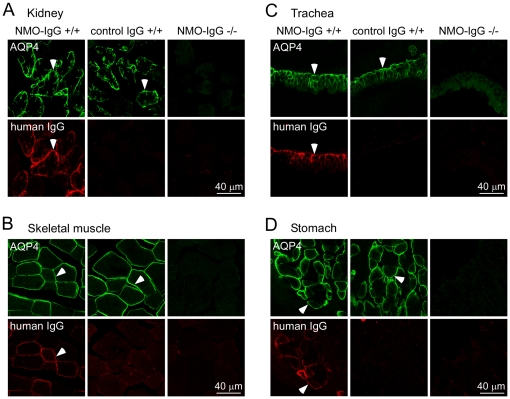
NMO-IgG localization to AQP4-expressing peripheral organs following intravenous administration.NMO-IgG or a control human IgG were injected intravenously in wild type and AQP4 knockout mice. After 24 hours, tissues were fixed and stained for AQP4 (green). NMO-IgG and control IgG were detected using a secondary anti-human antibody (red). Confocal fluorescence images shown of kidney (A), skeletal muscle (B), trachea (C) and stomach (D). Arrowheads indicate basolateral membrane of kidney collecting duct (A), skeletal muscle sarcolemma (B), basolateral membrane of tracheal surface epithelial cells (C), and basolateral membrane of gastric parietal cells (D). Data are representative of 3 mice per group.